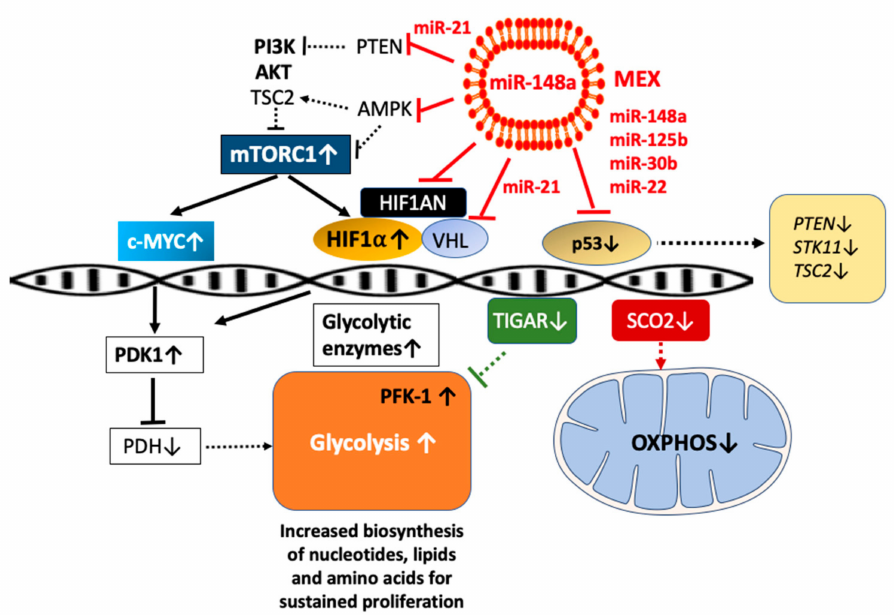
Figure 7. Predicted model of MEX miR-mediated regulation on glycolysis and mitochondrial ox- idative phosphorylation (OXPHOS). Upregulated mTORC1 signaling activates the expression of c-MYC and hypoxia-inducible factor 1 α (HIF-1 α ), which both upregulate the expression of pyruvate dehydrogenase kinase 1 (PDK1), resulting in an inhibition of pyruvate dehydrogenase (PDH), thereby activating glycolysis. Glycolysis provides key substrates of precursor molecules for biosynthetic pathways required for cell proliferation. MiR-148a and miR-21 promote glycolysis via targeting hypoxia-inducible factor 1 α inhibitor ( HIF1AN ) and von Hippel-Lindau tumor suppressor ( VHL ), respectively. Both are pivotal negative regulators of HIF-1 α , the key transcription factor of glycolysis. MEX miR-mediated suppression of p53 attenuates the expression of TP53-induced glycolysis and apoptosis regulator ( TIGAR ), thereby enhancing the activity of 6-phoshofructo-1 kinase (PFK-1), which promotes glycolysis. In addition, MEX miR-mediated suppression of p53 also reduces the expression of SCO cytochrome c oxidase assembly protein 2 ( SCO2 ), which operates at the inner membrane of the mitochondria, facilitating the assembly of cytochrome c oxidase complex in